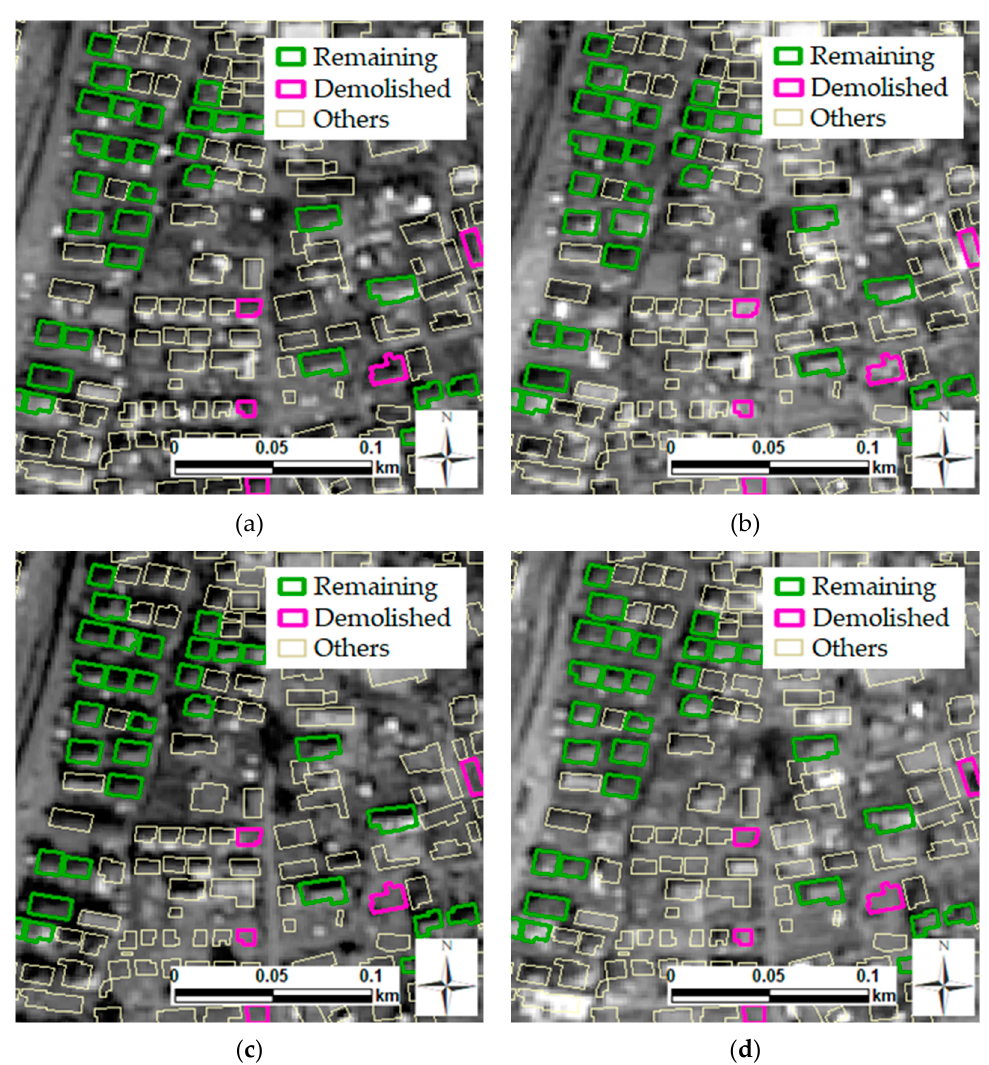
Figure 10. Training data with labels of demolished and remaining buildings and background image of SPOT observed on: ( a ) 20 March 2016; ( b ) 29 July 2016; ( c ) 1 January 2017; and ( d ) 25 March